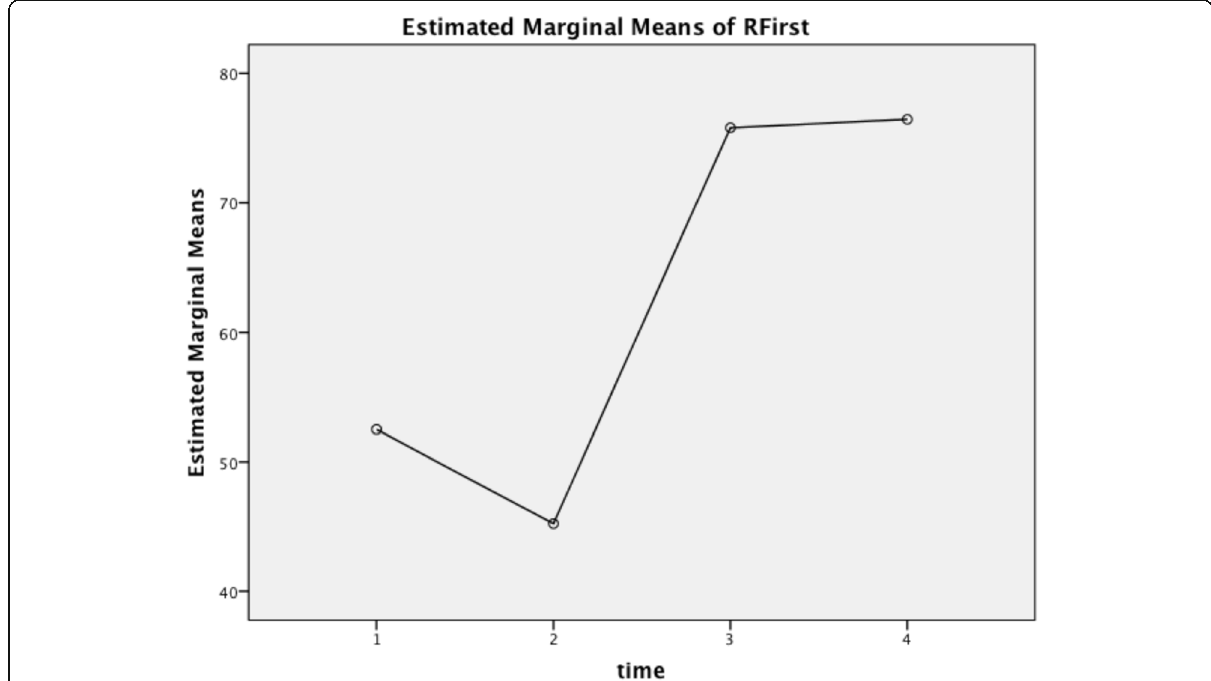
Fig. 10 Weighted Mean: First time incorporating scientific ideas for each water quality